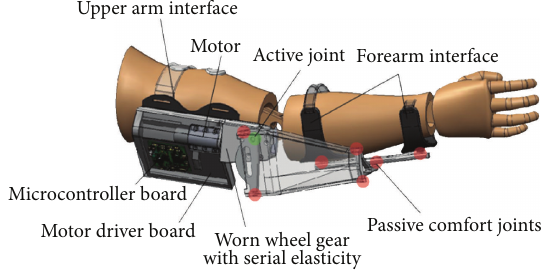
Figure 3: Mechanical design of the active orthosis. The red dots represent the positions of the passive degrees of freedom.